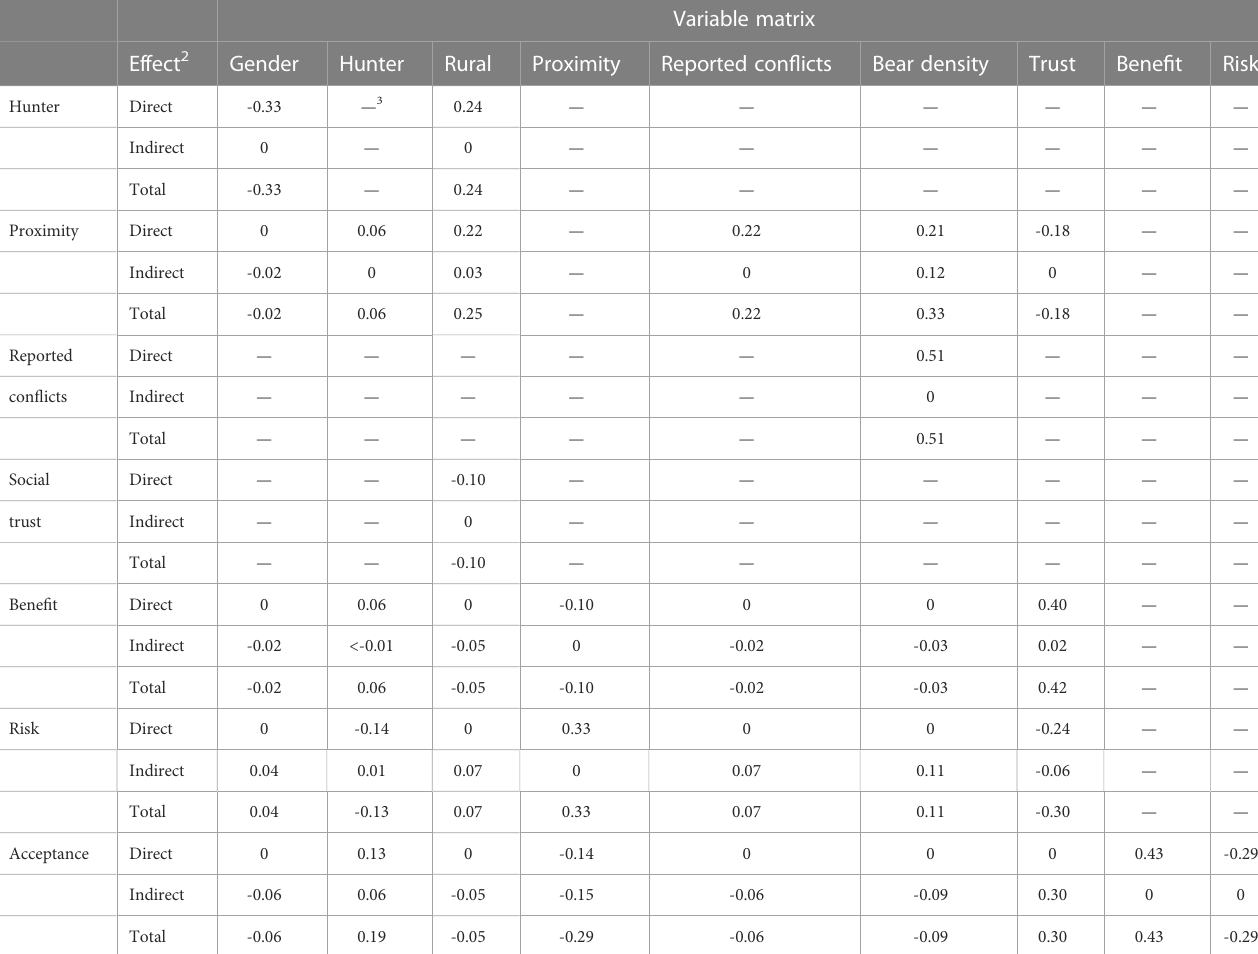
TABLE 2 Impact of exogenous and endogenous variables (rows) on one another